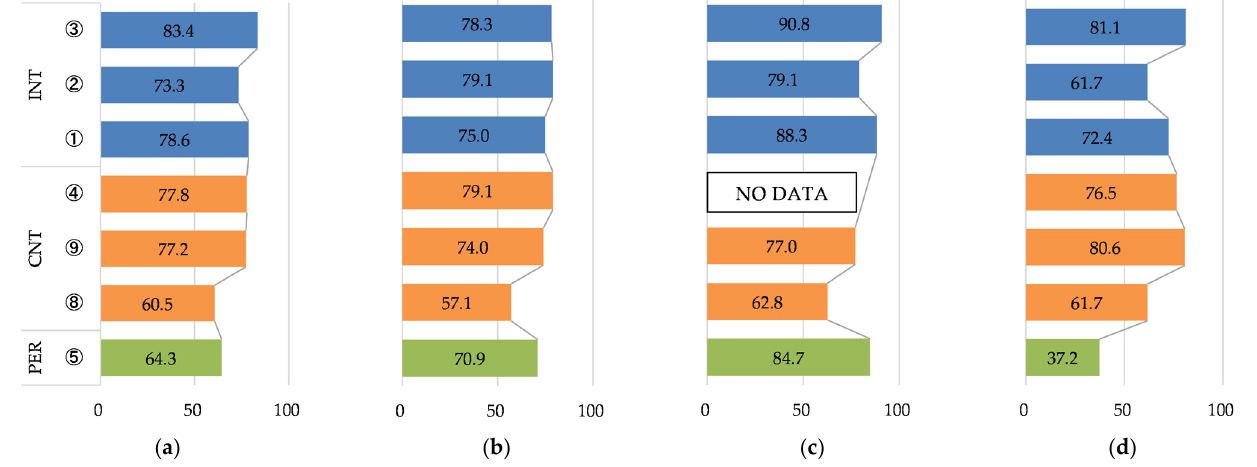
Figure 15. Summer comfort range percentage based on the JSEHMS for the ( a ) total average and in